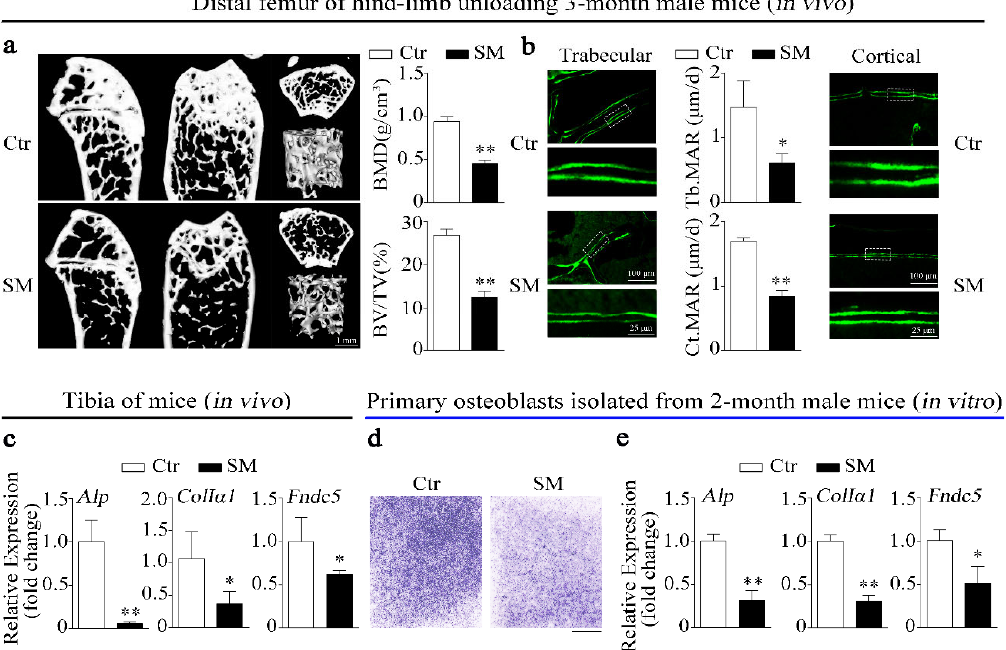
Figure 1. Irisin level, bone formation, and osteoblast di ff erentiation were decreased under simulated microgravity in vivo and in vitro. ( a ) Representative images showing three-dimensional trabecular architecture in distal femur and microCT analysis of microstructural bone parameters of the distal femurs including BMD (bone mineral density) and BV / TV (bone volume to tissue volume) in control and hind-limb unloading mice group. Scale bar, 1 mm; n = 6 mice per group. ( b ) Representative images showing new bone formation assessed and dynamic histomorphometric analysis of MAR (mineral apposition rate) by double calcein labeling in trabecular bone (left) and cortical bone (right) of distal femur from control and hind-limb unloading mice group. Upper scale bar, 100 µ m; lower scale bar, 25 µ m; n = 6 mice per group. ( c ) Real-time PCR analysis of Alp , ColI α 1 , and Fndc5 expressions in tibias of control and hind-limb unloading mice for 28 days; n = 4 mice per group. ( d ) Representative images of alkaline phosphatase (ALP) staining of primary osteoblasts cultured in random position machine for 48 h. Scale bar, 5 mm. ( e ) Real-time PCR analysis of osteogenic gene Alp , ColI α 1 , and Fndc5 expressions in primary osteoblasts after random position machine (RPM) for 48 h; n = 3. Gapdh was used as the internal control for messenger RNA (mRNA). Ctr: control, SM: simulated microgravity. All data are the mean ± SD. Statistical di ff erences between the two groups were determined by the Student’s t -test; * p < 0.05, ** p <